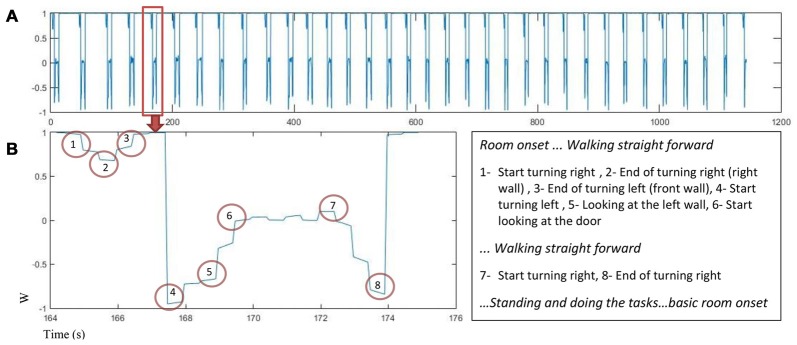
The quaternion number changes as a function of time for one participant (A)
w value for 34 rooms in about 1200 s. (B) Left: w changes in one room while participant is walking and turning, the turning points are marked, Right: turns marker description.